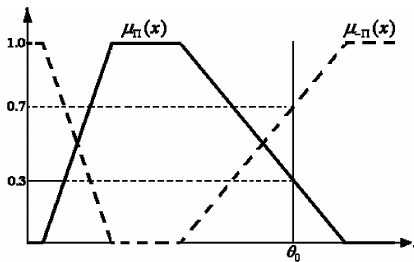
Fig. 4. H is accepted (rejected) with DA=0.3 (DR=0.7). 0